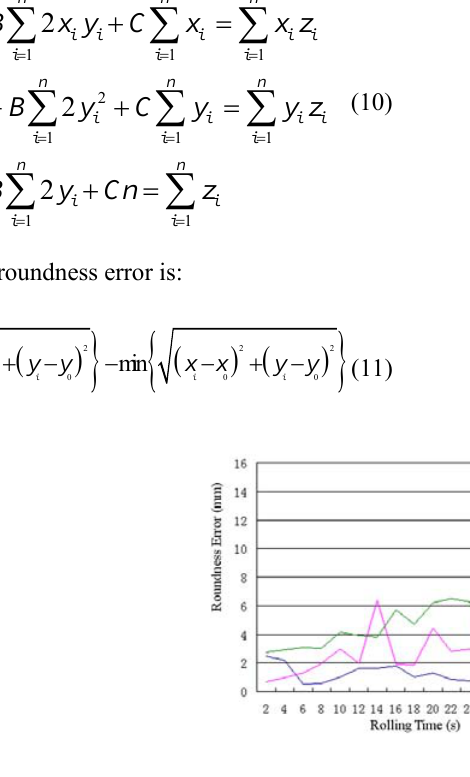
Fig. 7. The relation curves between feed speed and the roundness